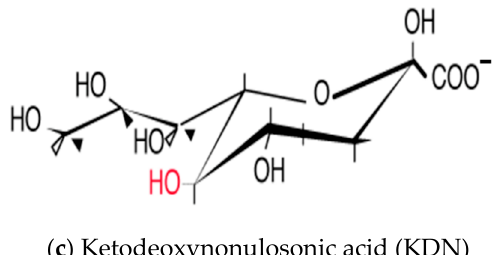
Figure 1. The structures of three most common Sialic Acids. ( a ) N-acetylneuramic acid (Neu5Ac), ( b ) N-acetylneuramic acid (Neu5Ac) and ( c ) Ketodeoxynonulosonic acid (KDN).